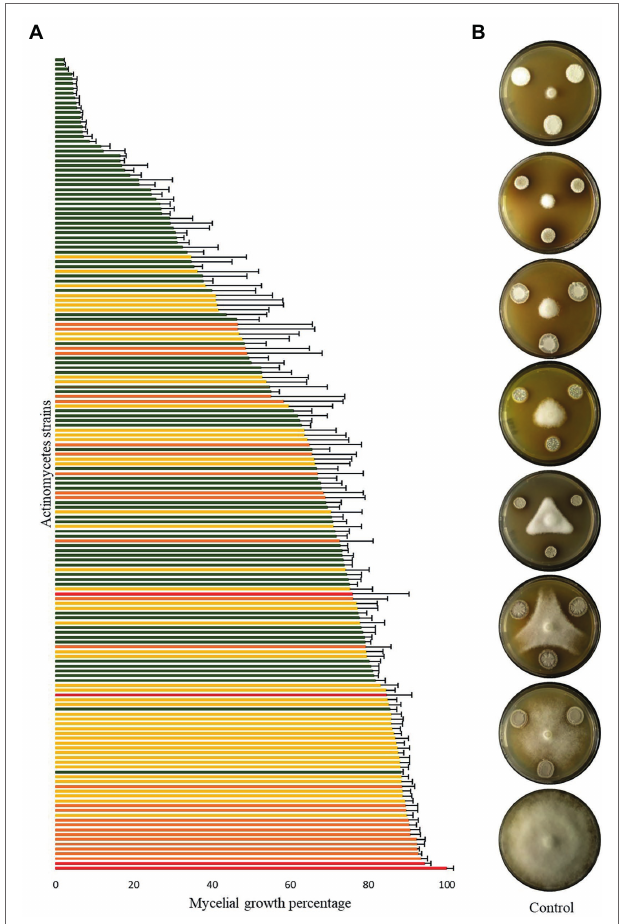
FIGURE 2 | Inhibition of Phytophthora infestans mycelial growth by Actinomycetes strains. (A) Bar chart showing P. infestans mycelium growth when co-cultured with the different isolates, as percentage of the control growth. Bars are averages of six replicates from two independent experiments with standard error, green, yellow, and orange bars represent statistically significant differences in comparison to the control (Student’s t -test; p < 0.001, p < 0.01, and p < 0.05, respectively), while red bars represent non-significant differences to the control. The growth of the control (red bar at the bottom of the chart) was set to 100%. (B) Representative plates of different strains showing various P. infestans growth percentages compared to the control (100% growth